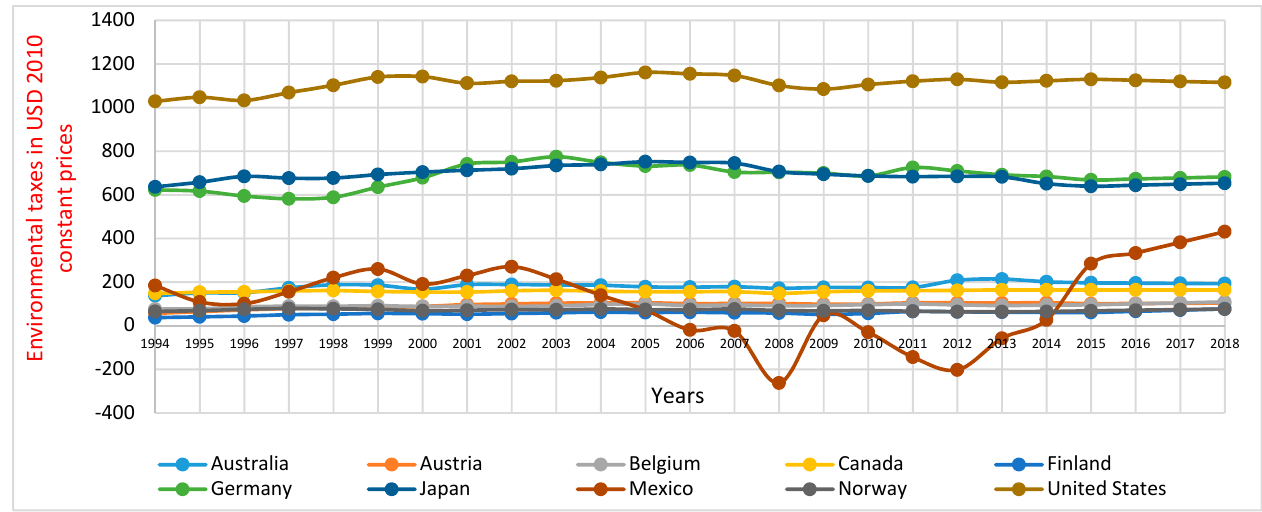
Figure A5. Ten OECD countries’ environmental taxes in US dollars—2010 constant prices.